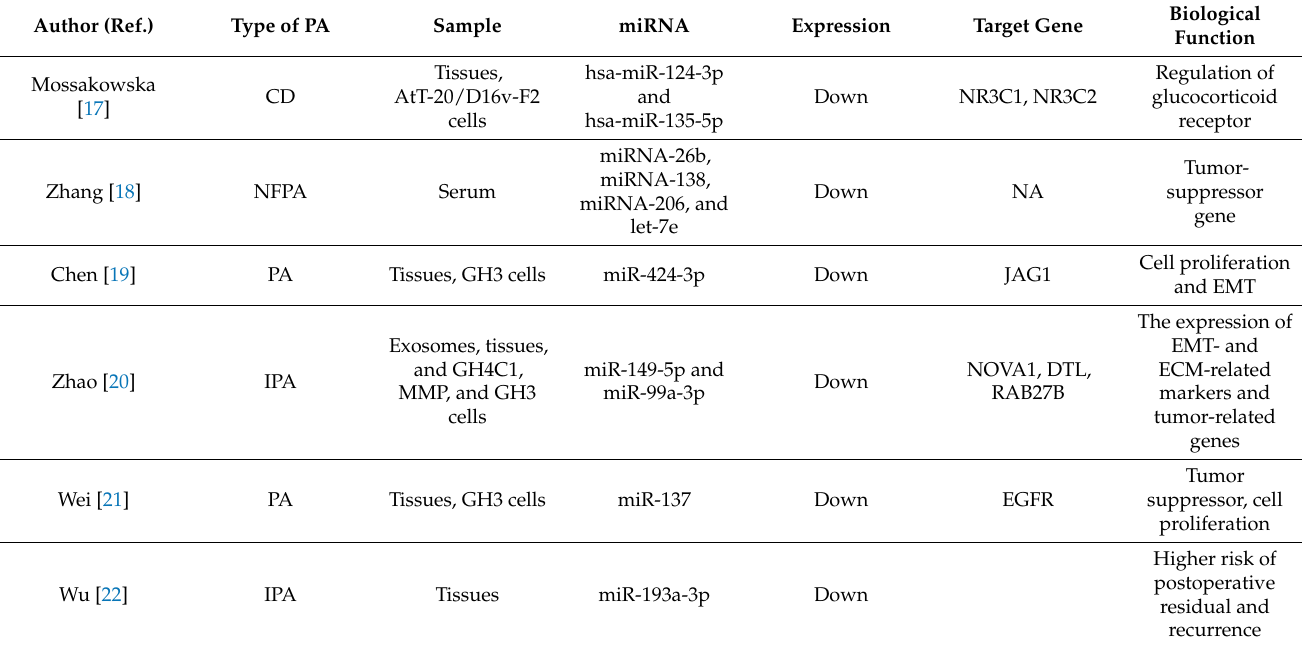
Table 1. Dysregulation of miRNA in different PA